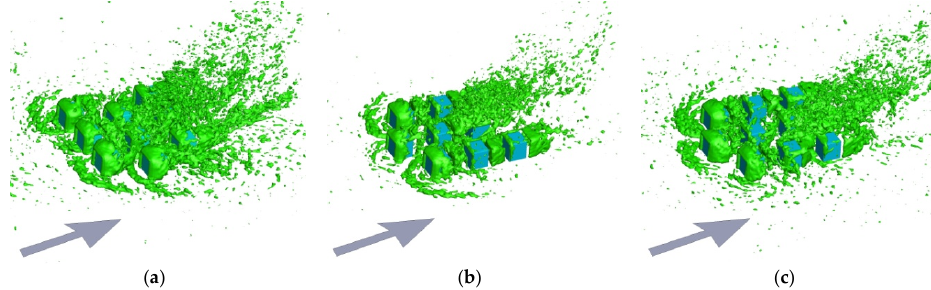
Figure 7. Snapshots of the Q criteria for ( a ) Case 1; ( b ) Case 2; ( c ) Case 3.